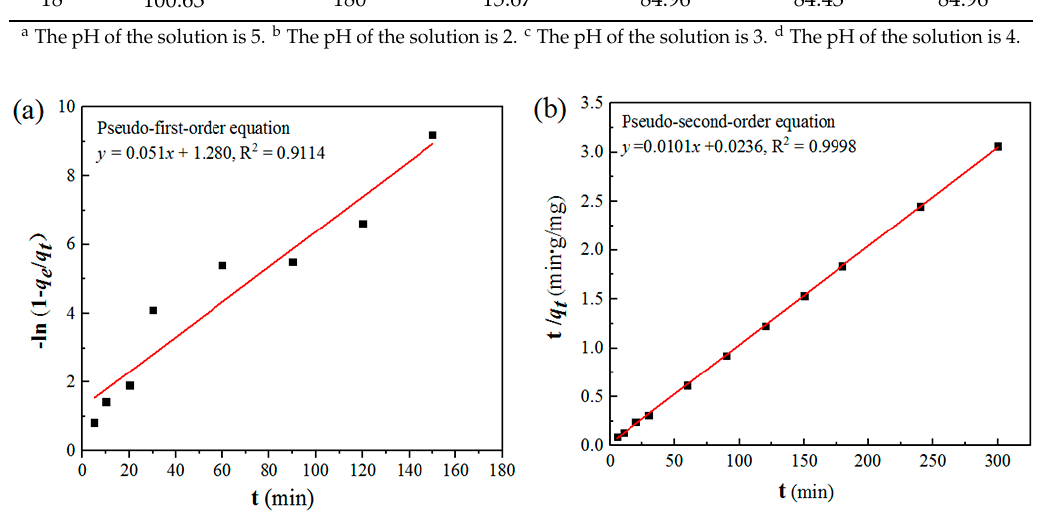
Figure 3. Concentration (100 mg/L) of Cu 2+ at 25 °C. ( a ) The pseudo-first-order kinetic model fitting results. ( b ) The pseudo-second-order kinetic model fitting results.